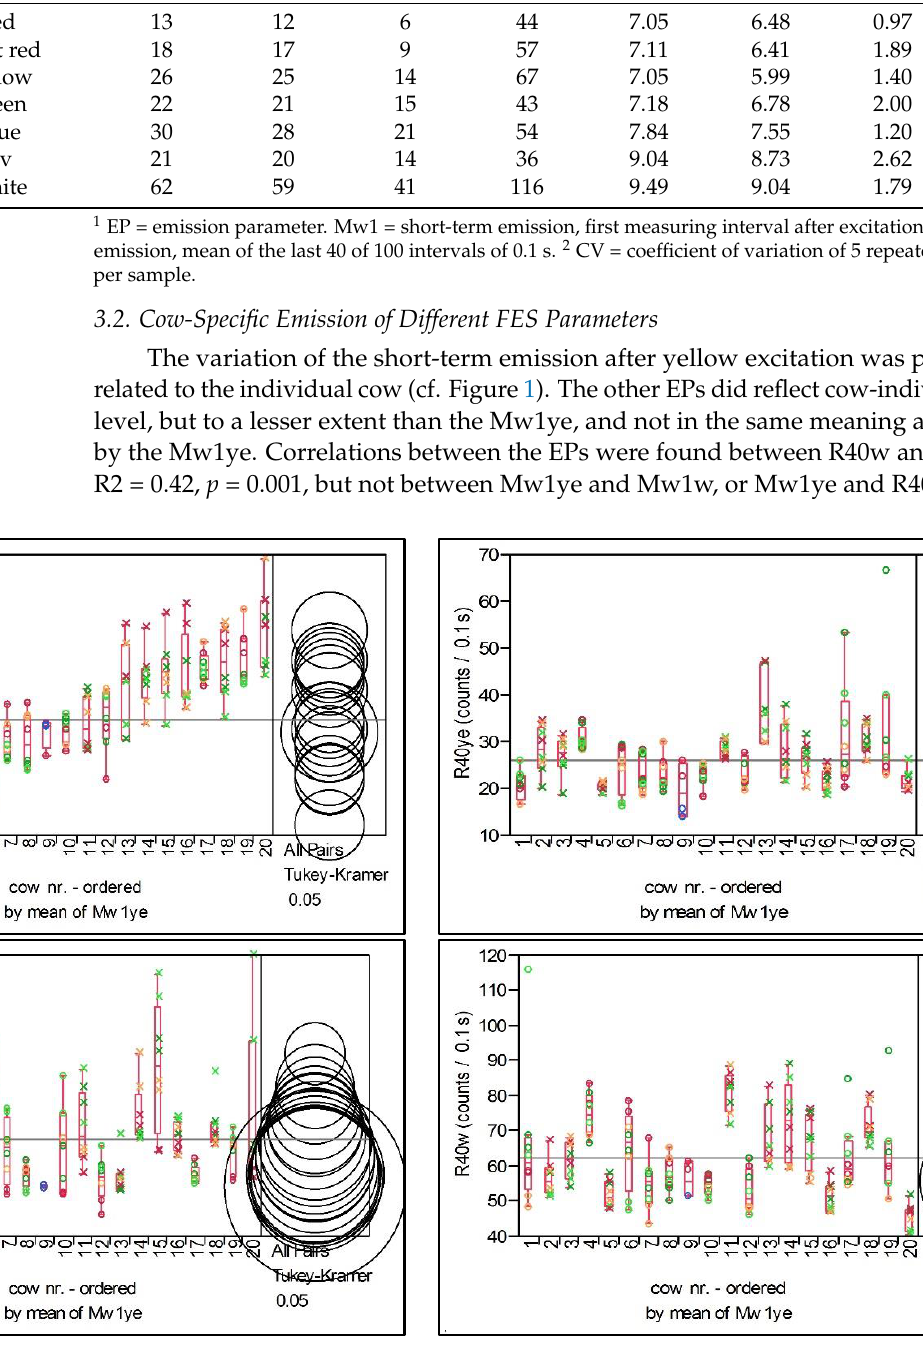
Figure 1. Cow-specific emission of the short-term and long-term EPs after yellow and white excitation (Mw1ye, Mw1w, R40ye, and R40w). Box plots represent the median and the upper and lower quartile of the eight samples per cow. Data points above or below the whiskers are considered outliers. X = disbudded cow, O = horned cow, green = pure hay diet, red = concentrate added diet, dark colored = 10 ◦ C, and light colored = 25 ◦ C (heat stress). The circles indicate the region of significant difference of the Tukey HSD Test; non-overlapping circles are significantly